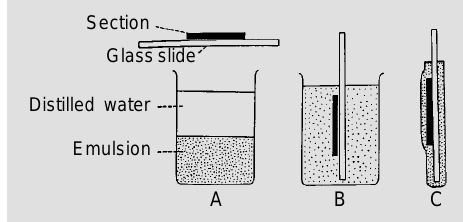
Figure 2 - Diagrams showing the procedures of the dipping method for LMRAG. A, After mounting sections on glass slides, bulk emulsion is melted and diluted with distilled water. B, The glass slides are dipped into the melted emulsion one by one. C, The dipped glass slides are pulled up and dried, exposed and